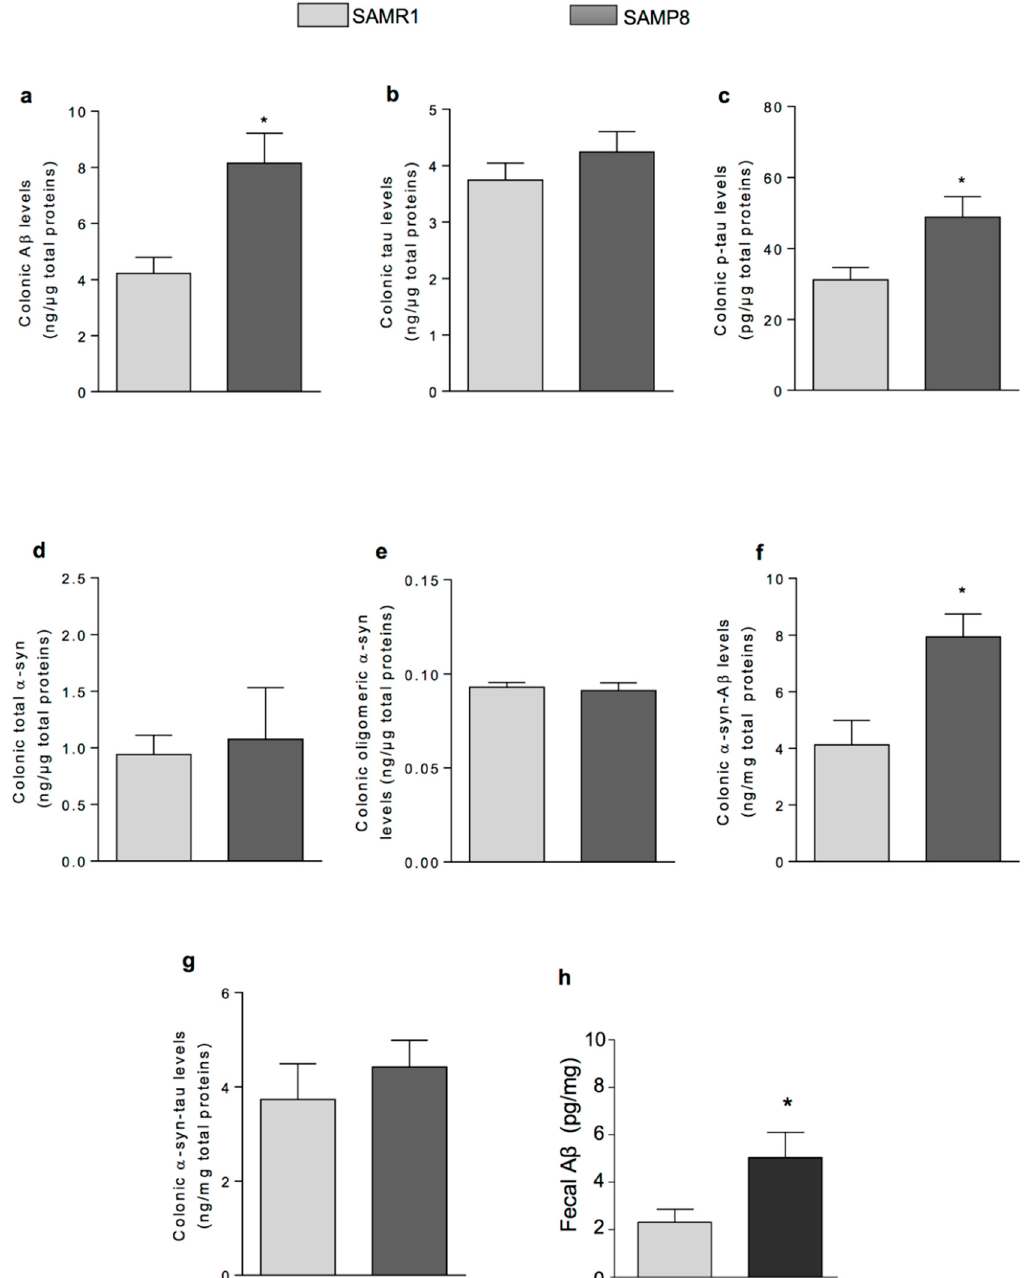
Figure 3. Quantitative detection of neurodegeneration-related proteins in colonic tissues and faecal specimens. The levels of: colonic A β ( a ); tau ( b ); p-tau ( c ); total α -syn ( d ); oligomeric α -syn ( e ); α -syn-A β ( f ); and α -syn-tau ( g ) were determined in SAMP8 and SAMR1 mice at six months by specific immunoenzymatic assays. ( h ) The levels of faecal A β were quantified in SAMR1 and SAMP8. Data are expressed as mean ± S.E.M. from eight animals. * p < 0.05, significant difference versus SAMR1. Statistics: Student t -test (for unpaired data).